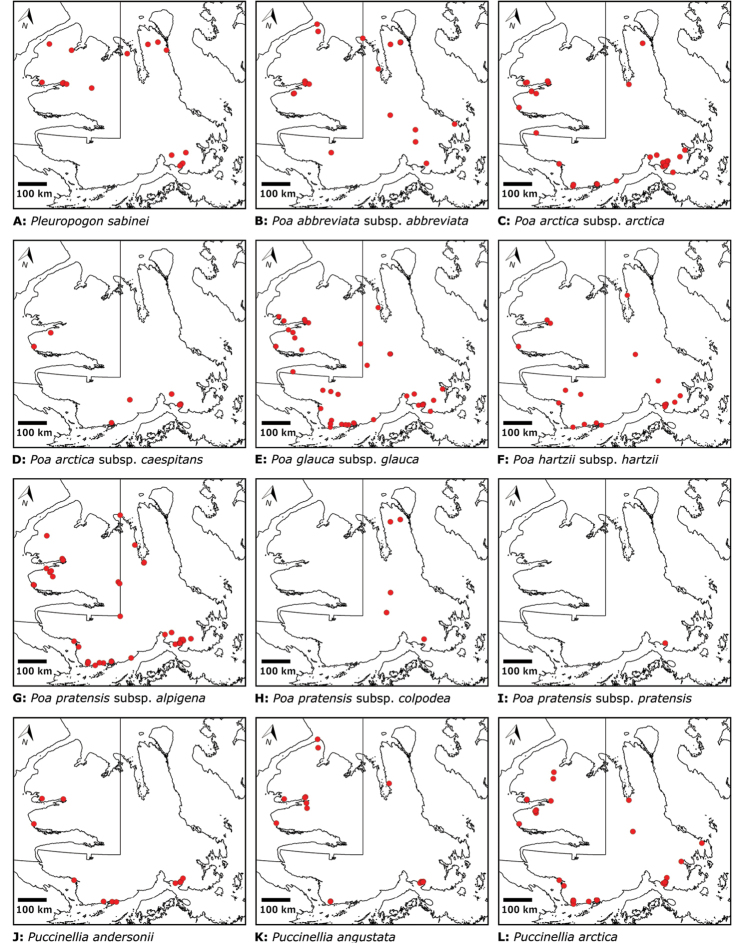
Species distribution maps. Poaceae: APleuropogon
sabineiBPoa
abbreviata
subsp.
abbreviataCPoa
arctica
subsp.
arcticaDPoa
arctica
subsp.
caespitansEPoa
glauca
subsp.
glaucaFPoa
hartzii
subsp.
hartziiGPoa
pratensis
subsp.
alpigenaHPoa
pratensis
subsp.
colpodeaIPoa
pratensis
subsp.
pratensisJPuccinellia
andersoniiKPuccinellia
angustataLPuccinellia
arctica.